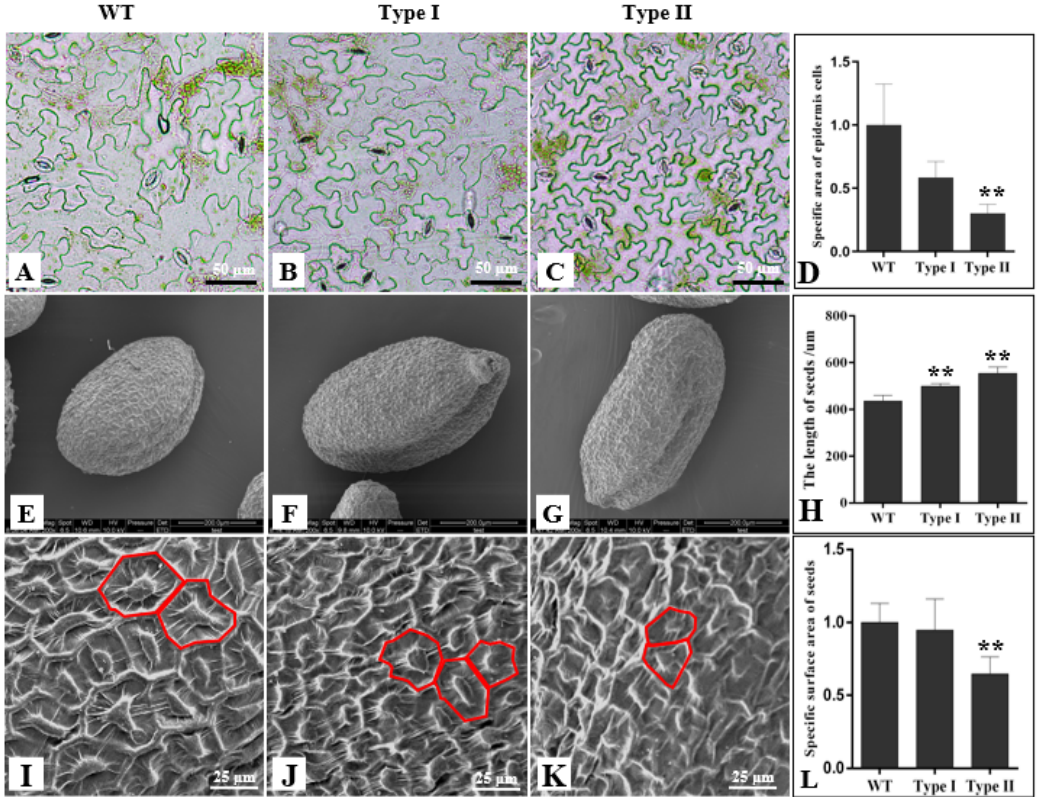
Figure 5. Observation of epidermal cells in transgenic Arabidopsis. Epidermal cells of wild type ( A ), Type I ( B ), and Type II ( C ) leaves. ( D ). Statistical analysis of the relative epidermal cell size between wild-type, Type I, and Type II leaves. SEM observation of cell size of wild type ( E ), Type I ( F ), and Type II ( G ) seeds. ( H ). Statistical analysis of the length of wild-type, Type I, and Type II seeds. SEM observation of epidermal cell size of wild-type ( I ), Type I ( J ), and Type II ( K ) seeds. ( L ). Statistical analysis of the epidermal surface area between wild-type, Type I, and Type II seeds. WT, wild-type seeds; Type I, Type I transgenic seeds; Type II, Type II transgenic seeds. ** P ≤ 0.01 with t -test.